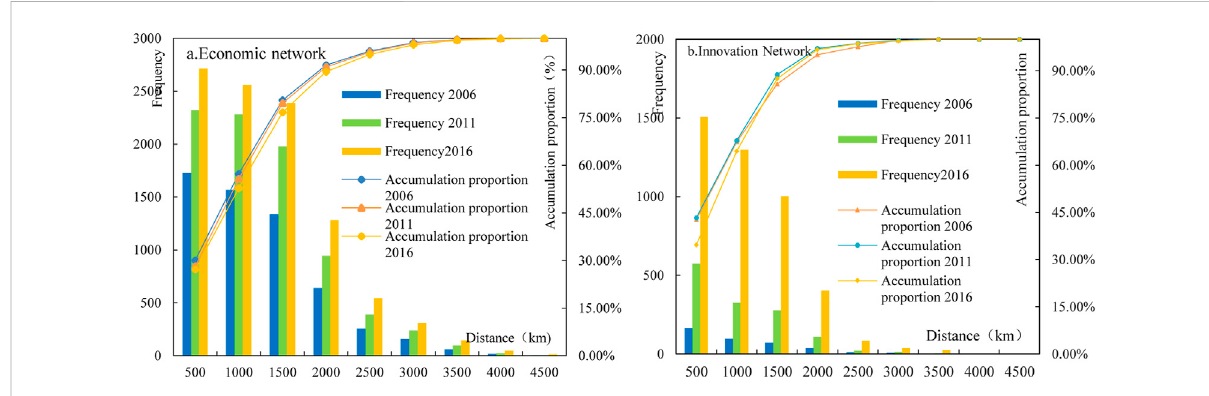
FIGURE 3 Distribution characteristics of the economic network and innovation network distance between